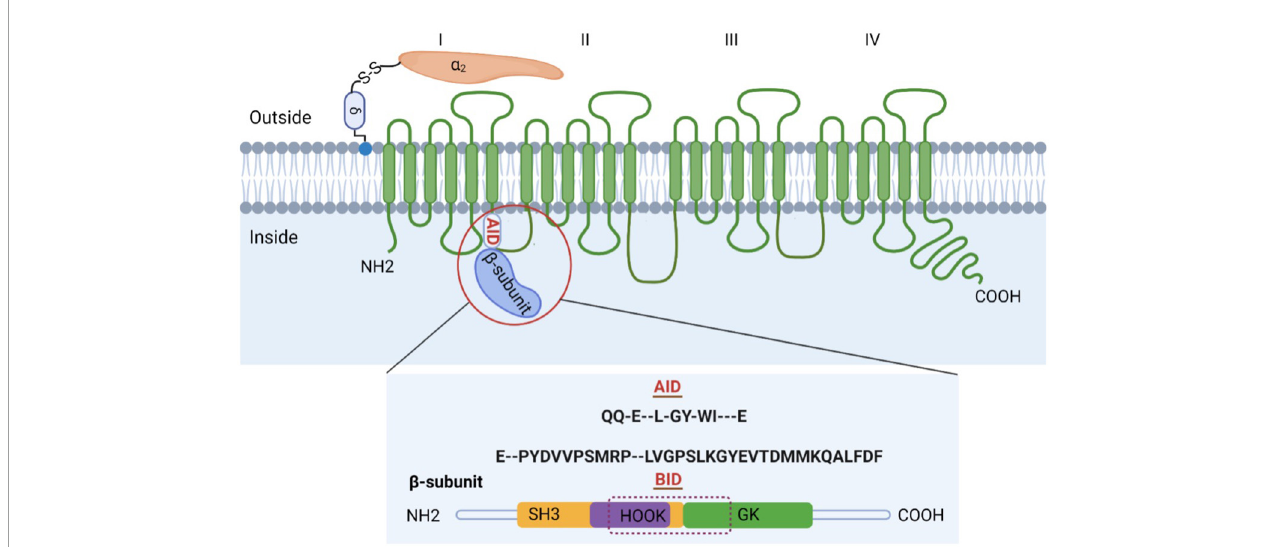
FIGURE1 Subunit composition of high voltage-gated calcium channels (VGCCs). Schematic representation of the predicted transmembrane topology of VGCCs subunits. The complex is composed of the pore-forming subunit α 1 (175 kDa) and two auxiliary subunits: α 2 δ and β . The AID, marked in red, is located on the I–II loop. β subunit is comprised of GK domain, Src homology 3 (SH3), HOOK region, NH2 terminus, and carboxyl terminus, with BID spanning across SH3-HOOK-GK motif. Both AID and BID have a conserved consensus motif, that is, QQ-E–L-GY-WI—E (AID) and E–PYDVVPSMRP–LVGPSLKGYEVTDMMKQALFDF (BID) (36).